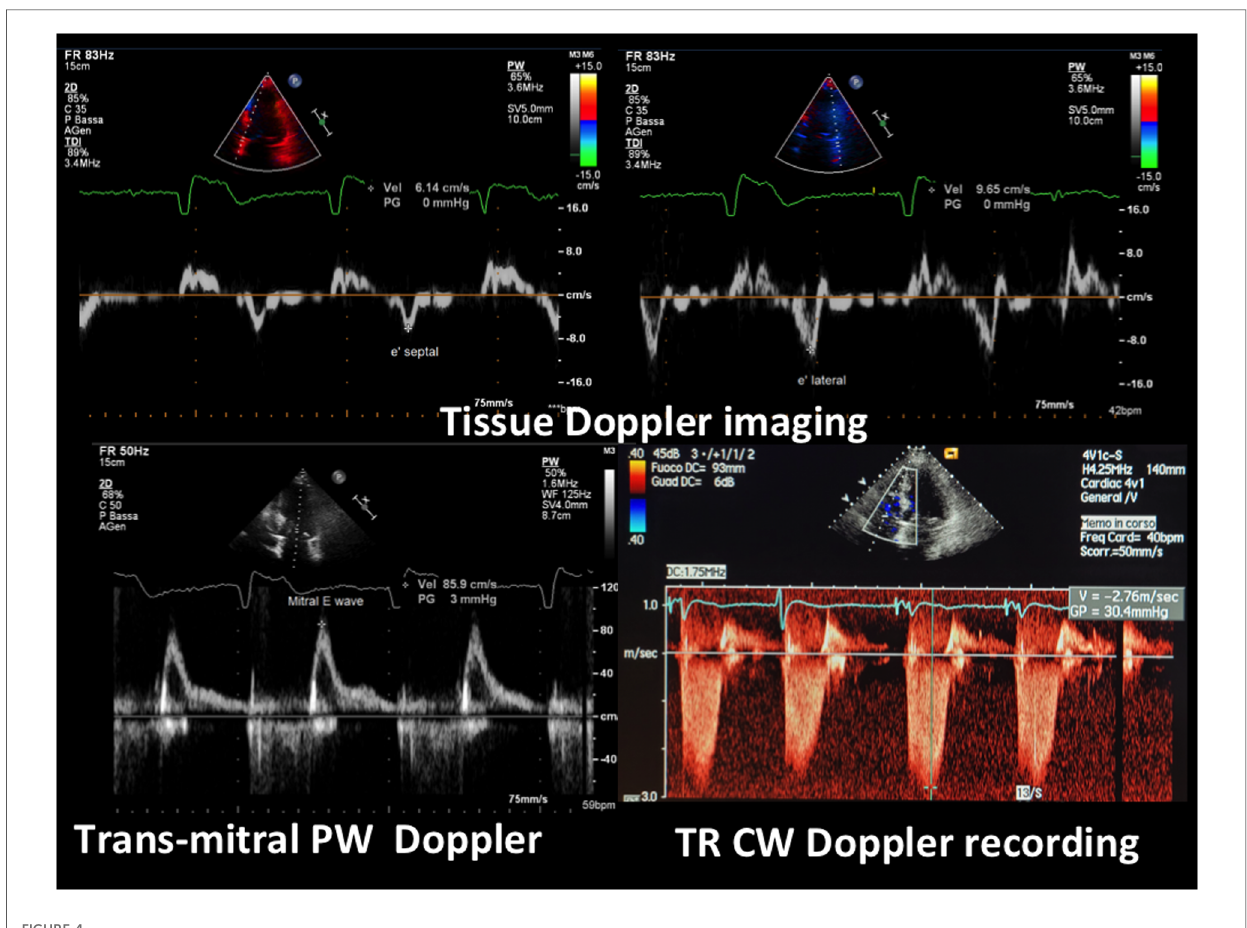
FIGURE 4 E/e ’ and pulmonary pressure evaluation by transthoracic Doppler. At the top, tissue Doppler imaging of the movement of the septal (on the left, e ’ septal wave) and of the lateral mitral annulus (on the right, e ’ lateral wave); at the bottom (on the left) transmitral blood fl ow Doppler recording (mitral E wave) (the A wave is lacking since the rhythm is atrial fi brillation). The E/e ’ ratio is elevated, indicating a high mean left atrial pressure con fi rmed by the elevated pulmonary pressure, as assessed by the maximal velocity of the TR jet (>2.7 cm/s) (bottom right). PW=pulsed Doppler; CW=continuous Doppler; TR= tricuspid